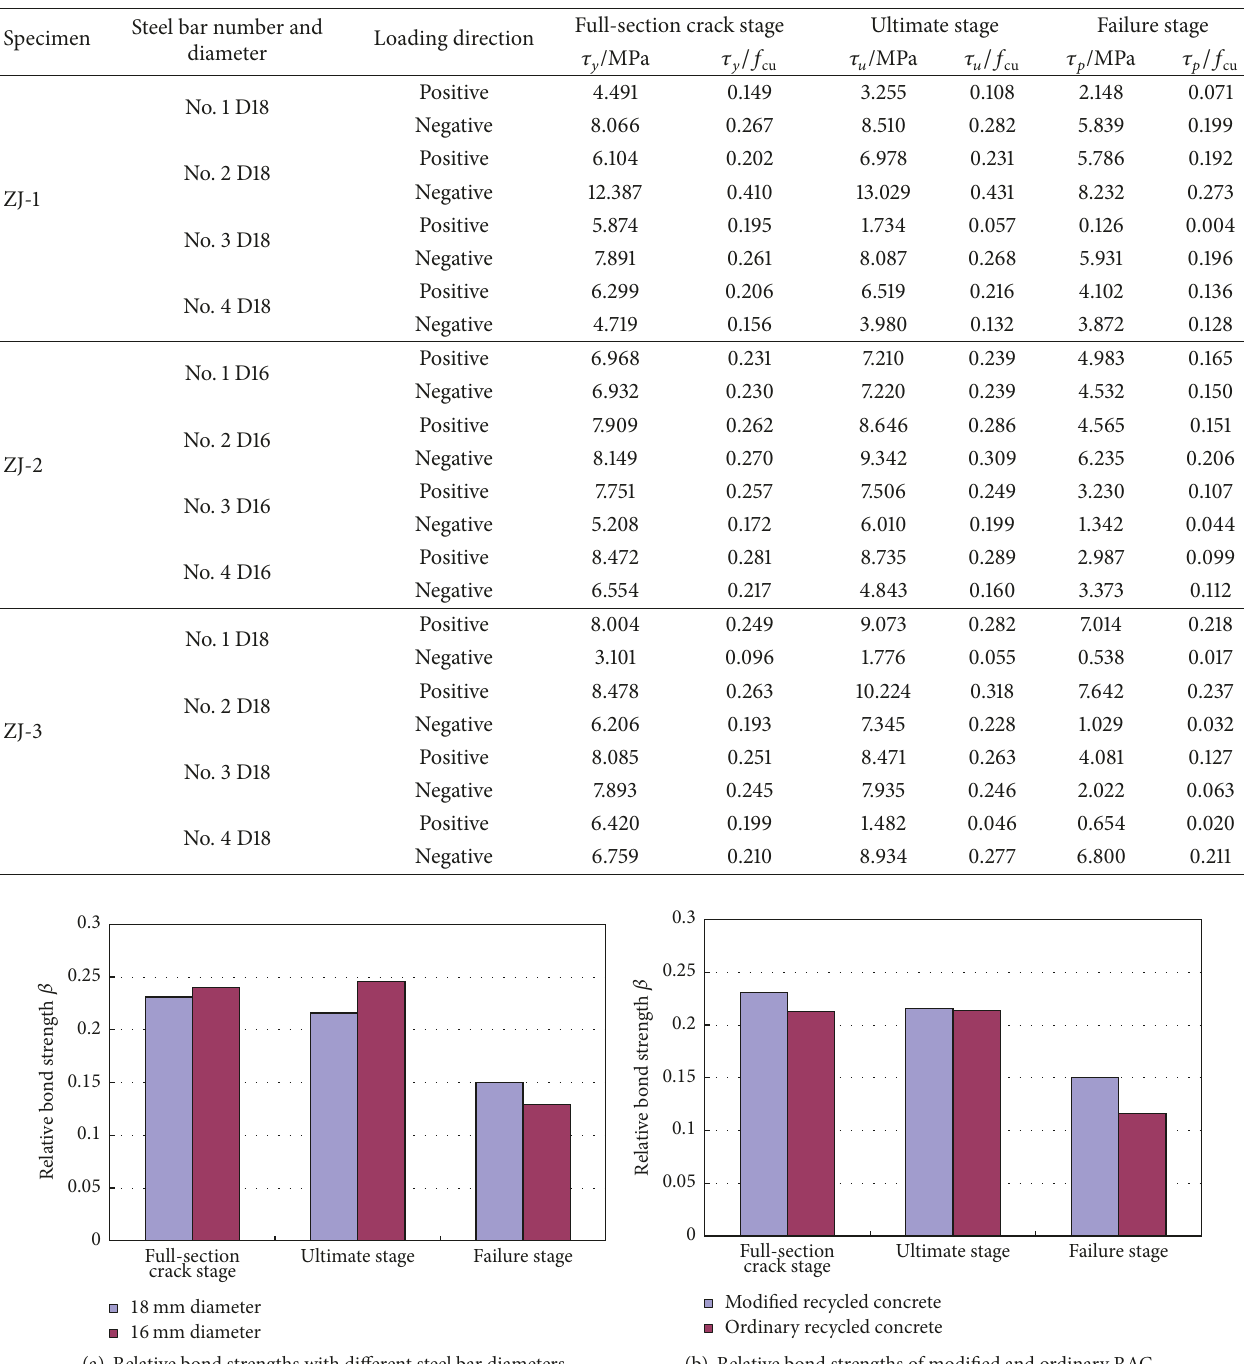
Table 4: Bond stress on longitudinal steel bar crossing joint in each of the loading stages. Specimen